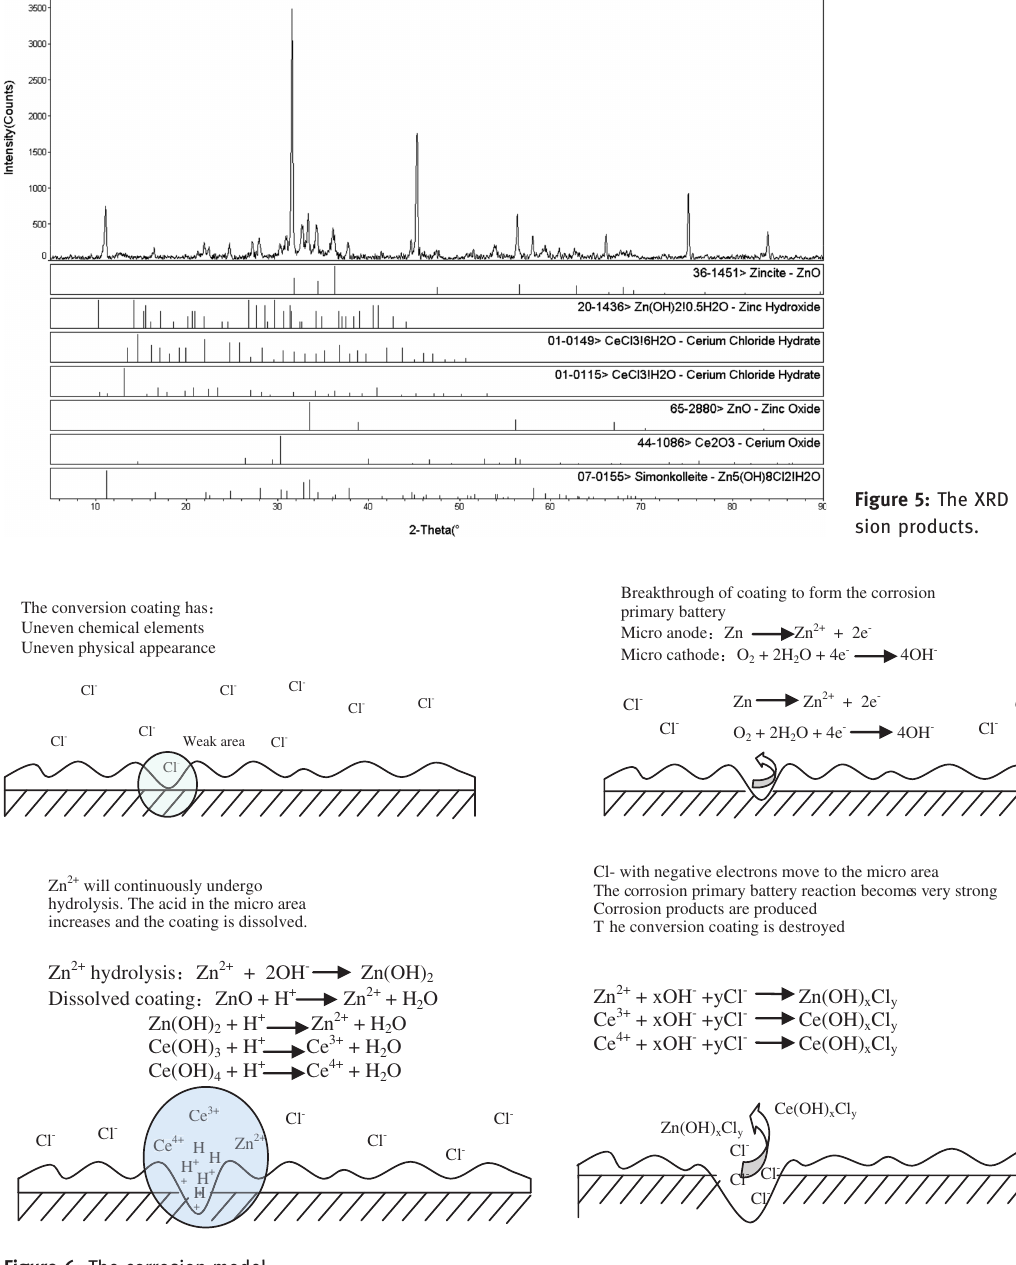
Figure 6: The corrosion